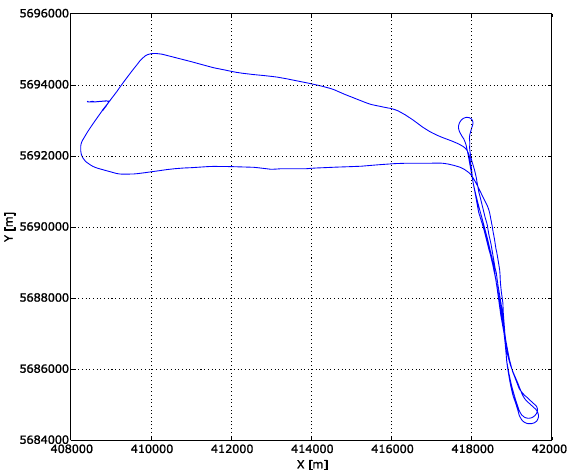
Figure 5. Trajectory line in top view. Flight